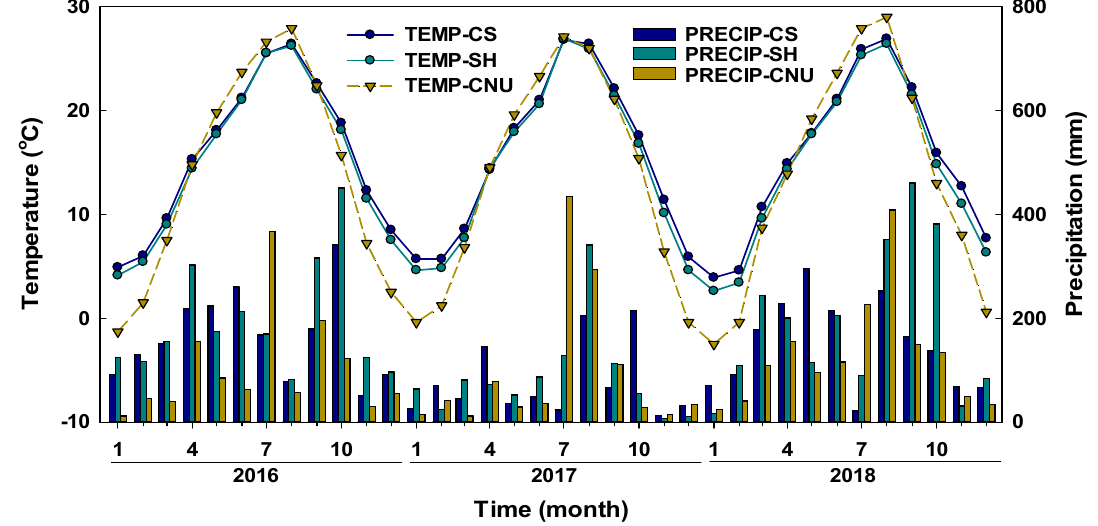
Figure 1. Monthly temperature and precipitation at Cheongsu (CS) and Seonheul (SH) Gotjawal in Jeju Island and Chungnam National University (CNU) Experimental Forest in Daejeon from 2016 to 2018.